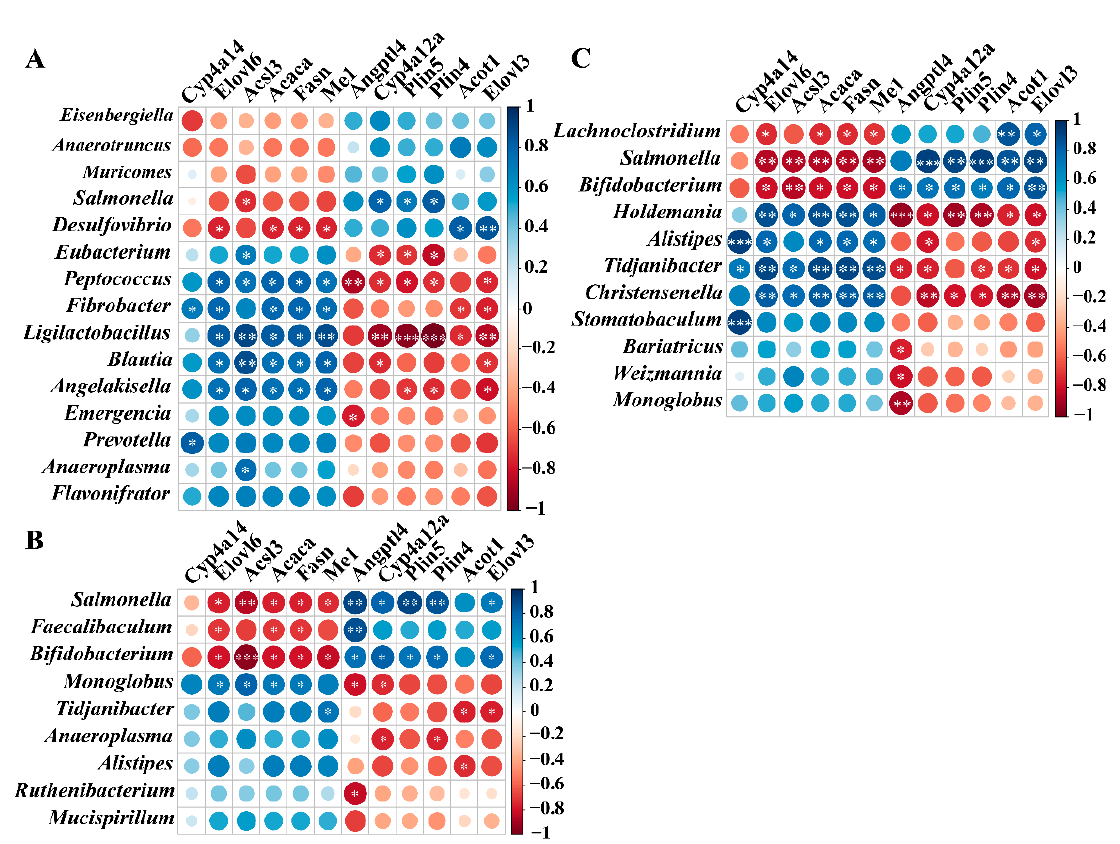
Figure 7. Interactions between gut microbiota and the expressions of genes related to lipid metabolism in the liver. ( A – C ) Spearman correlations of gut microbiota from fecal ( A ), colon ( B ), and cecal contents ( C ) with genes involved in lipid metabolism in the liver. Blue and red represent positive and negative correlations, respectively; * p < 0.05; ** p < 0.01; *** p < 0.001; n =